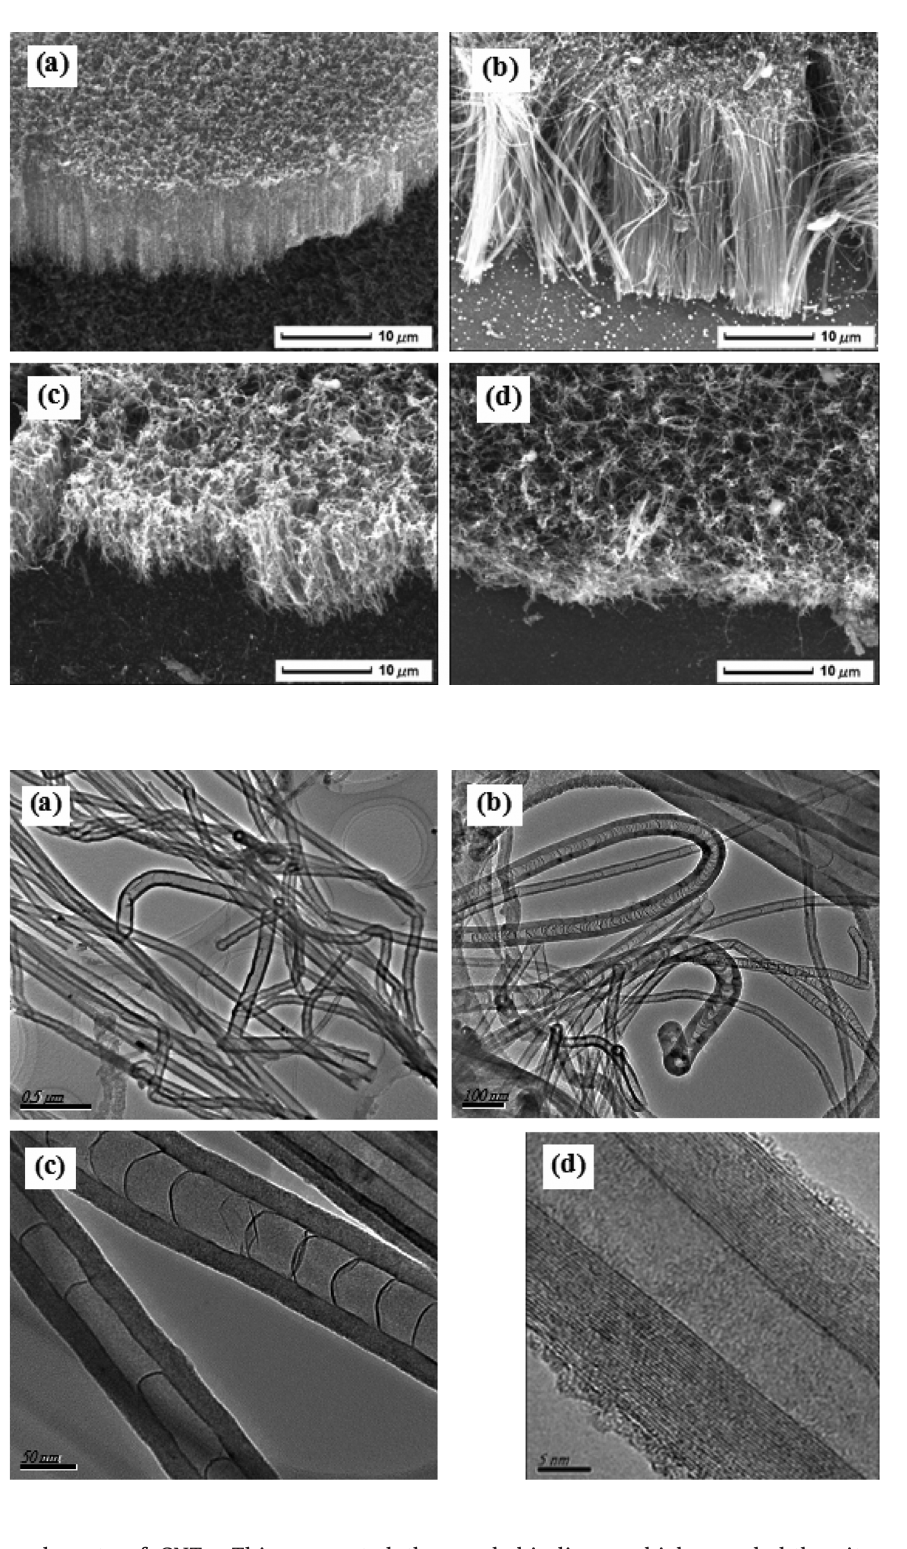
Figure 5: TEM images of aligned carbon nanotubes (a) vertical CNTs, (b) coiled CNTs, (c) bamboo-shaped structure, (d) HRTEM image of single